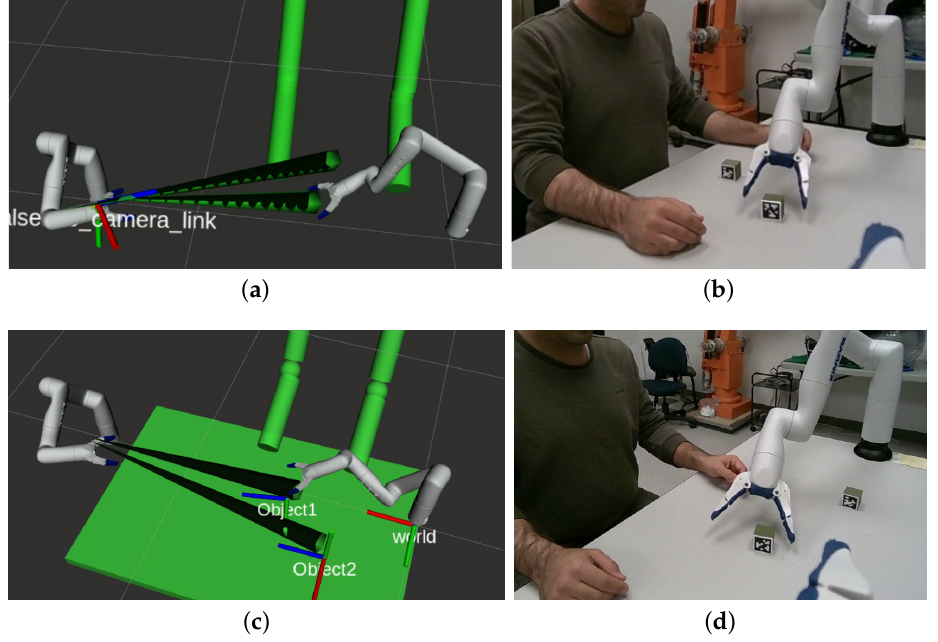
Figure 12. Two examples of the test cases: ( a , c ) are the Rviz visualizations of the virtual environment, while ( b , d ) are photos of the setup just before grasping the